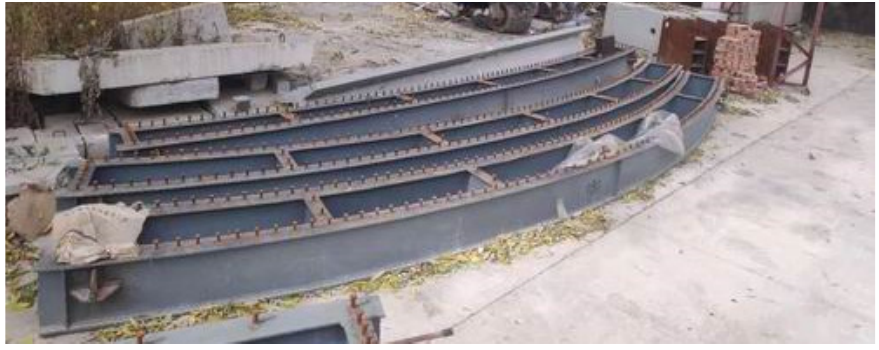
Figure 2. Details of the test specimens (in units of mm).